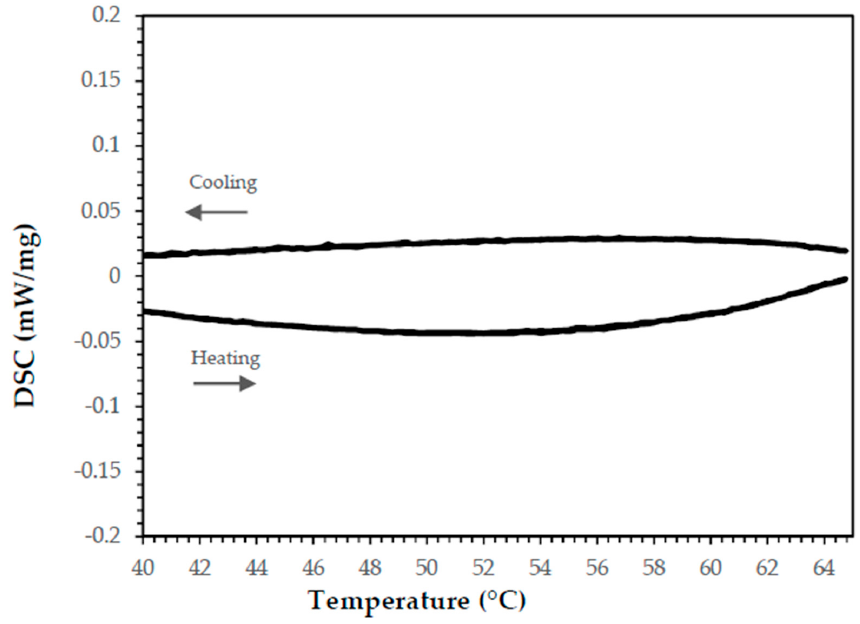
Figure 6. DSC results for endothermic and exothermic capacity for epoxy resin (Resolcoat ® VLSUV). Organic PCM-Epoxy Composites